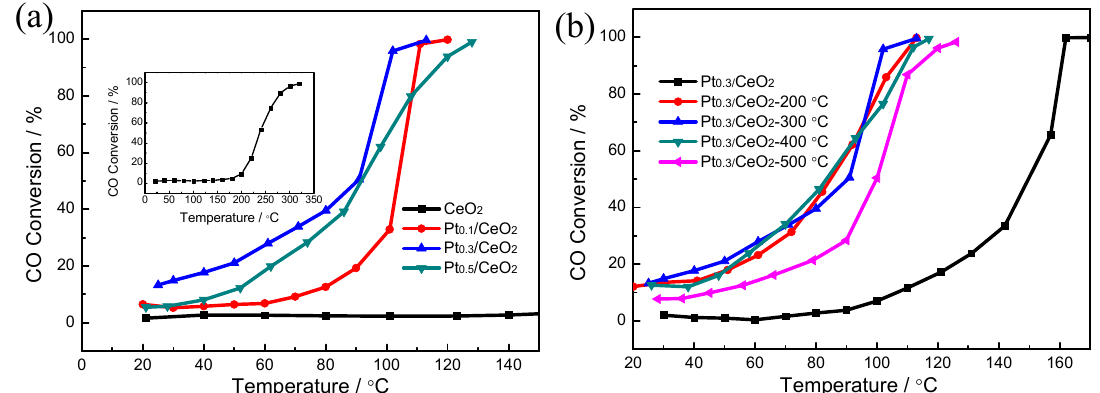
different temperatures. The inset image of ( a ) is the complete conversion curve for CeO 2 .